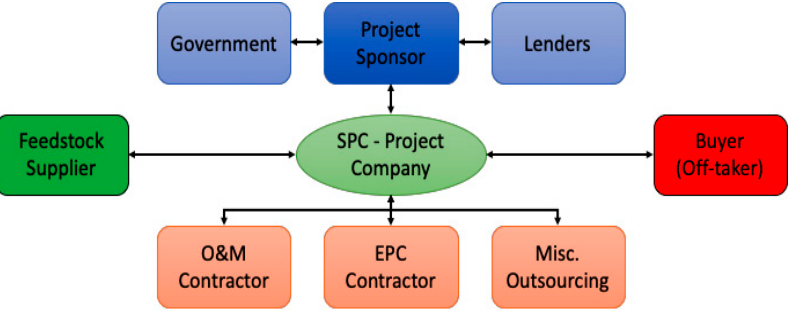
Figure 1. Project company model (modified from [4]).